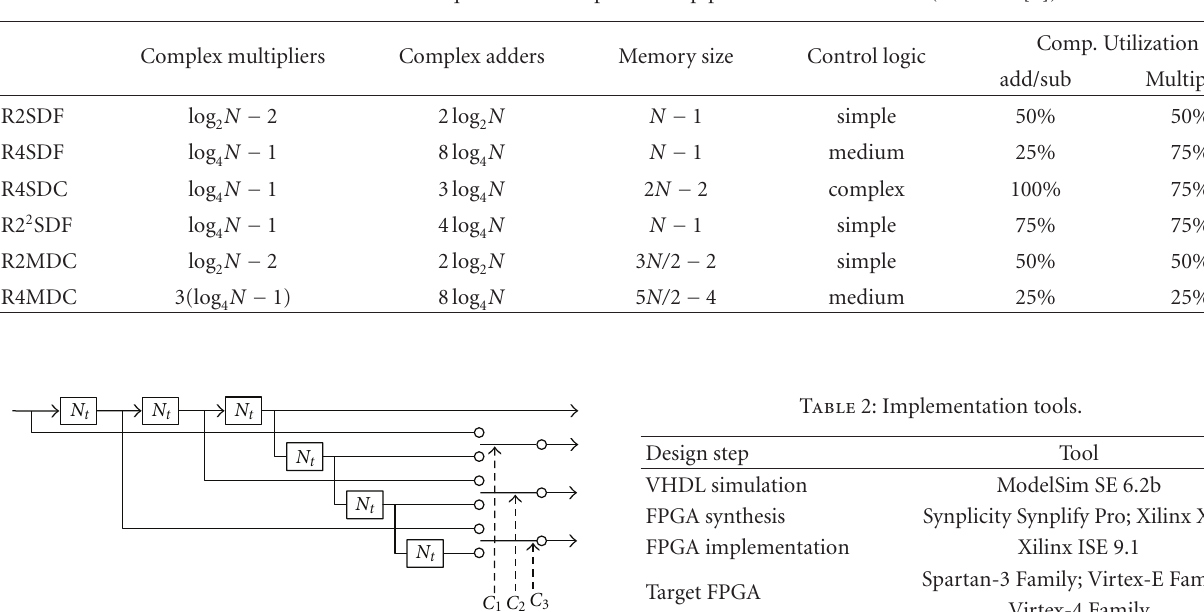
Table 1: Hardware resource requirements comparison of pipeline FFT architectures (based on [4]).